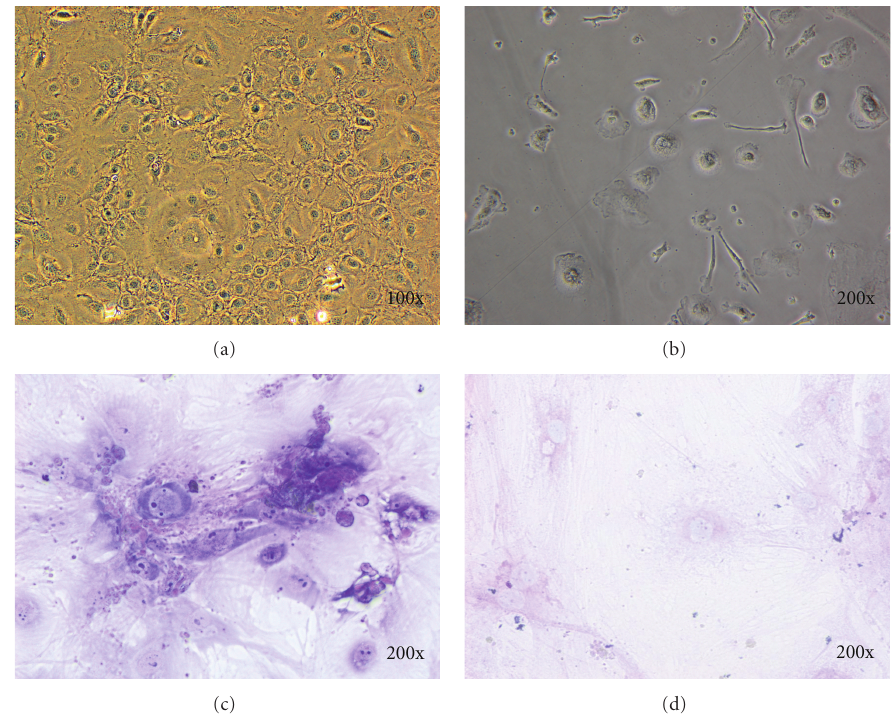
Figure 2: Characteristics of chondrocyte derived from mouse DPSC. After chondrogenic induction, the cytoplasm contracted toward the nucleus and formed spherical cells without branch (a and b). Glycosaminoglycans in chondrocyte tissue were stained by toluidine blue and showed blue in colors (c). Control groups without chondrogenic induction